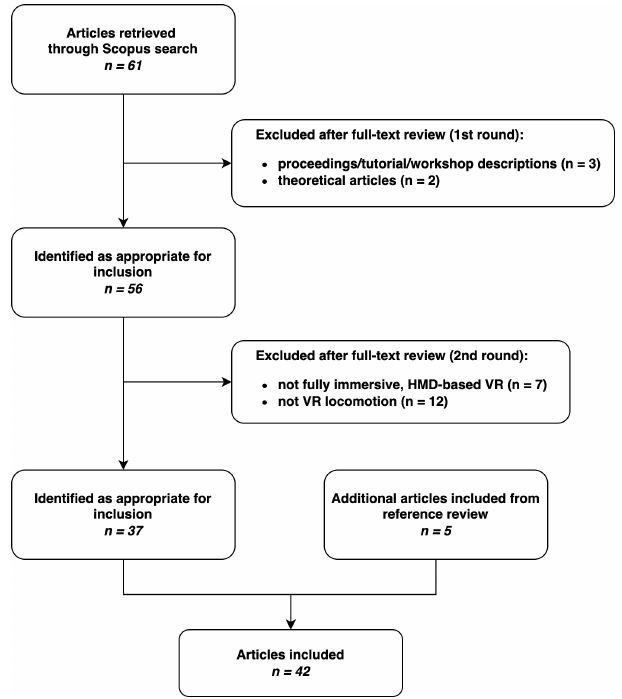
Figure 2. Flowchart of included/excluded